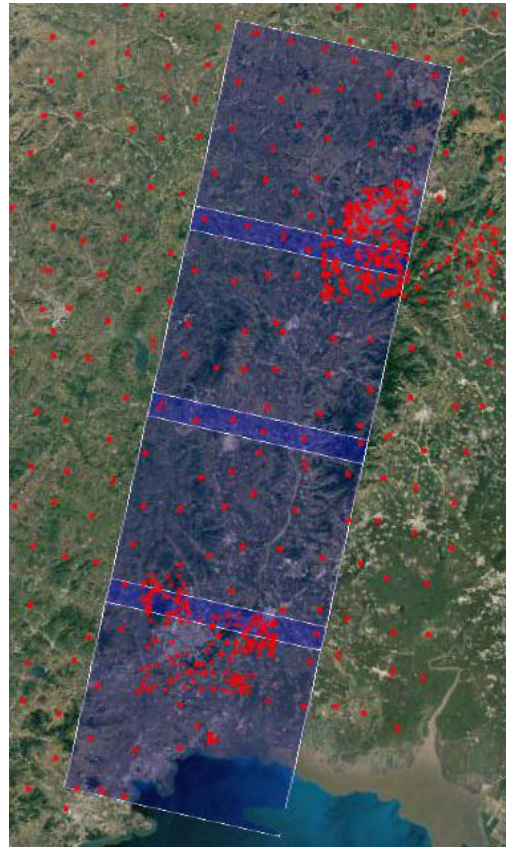
Figure 1. The schematic diagram of the experimental area and distribution of GCPs